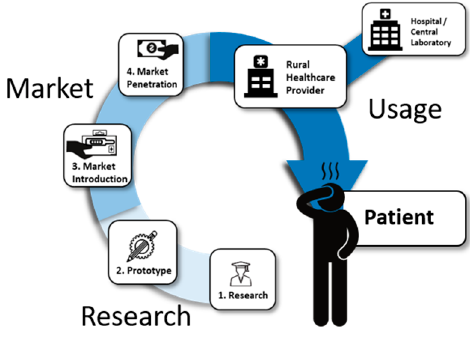
Figure 3. Segmentation of stages a PoC device has to pass to be able to bring a benefit to the patient.